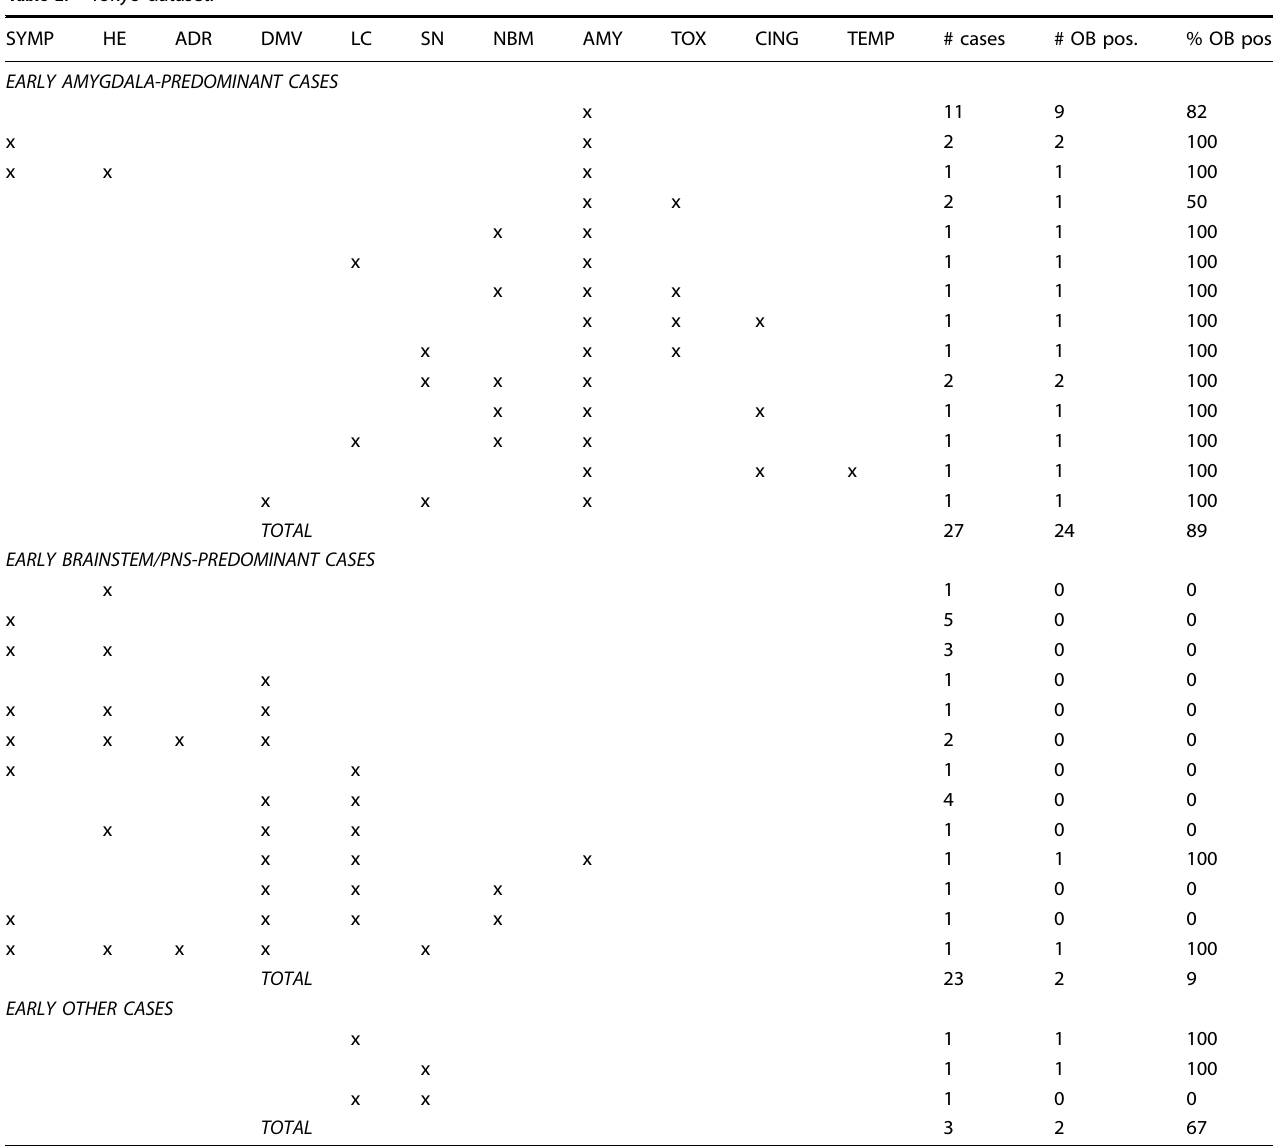
Table 2. Tokyo dataset.